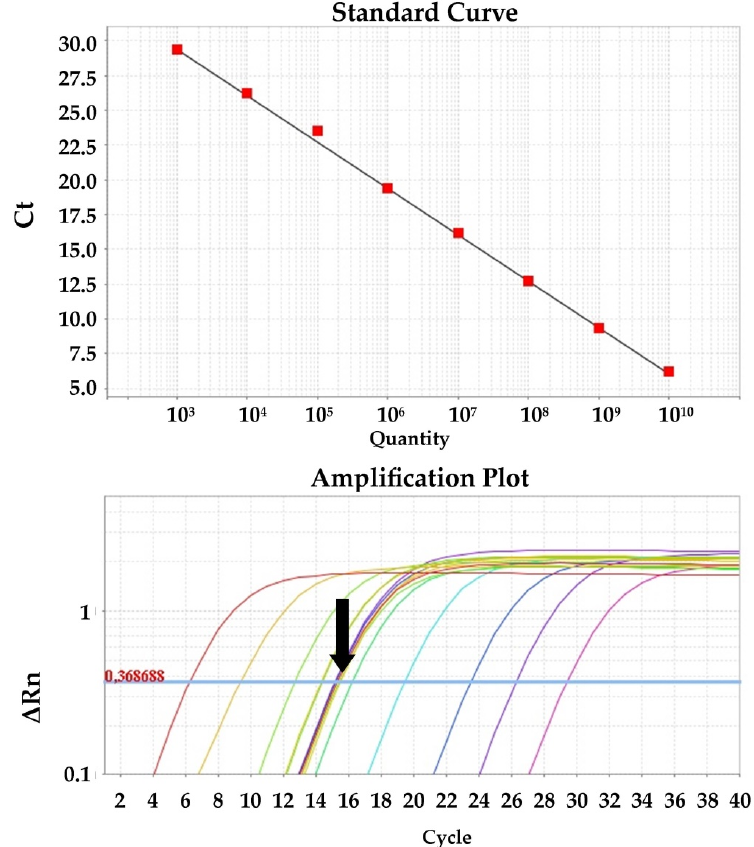
Figure 4. RT-qPCR standard curve using the SIV_Set_1 (M gene) primer set and the amplification plot with reference samples indicated with the black arrow.